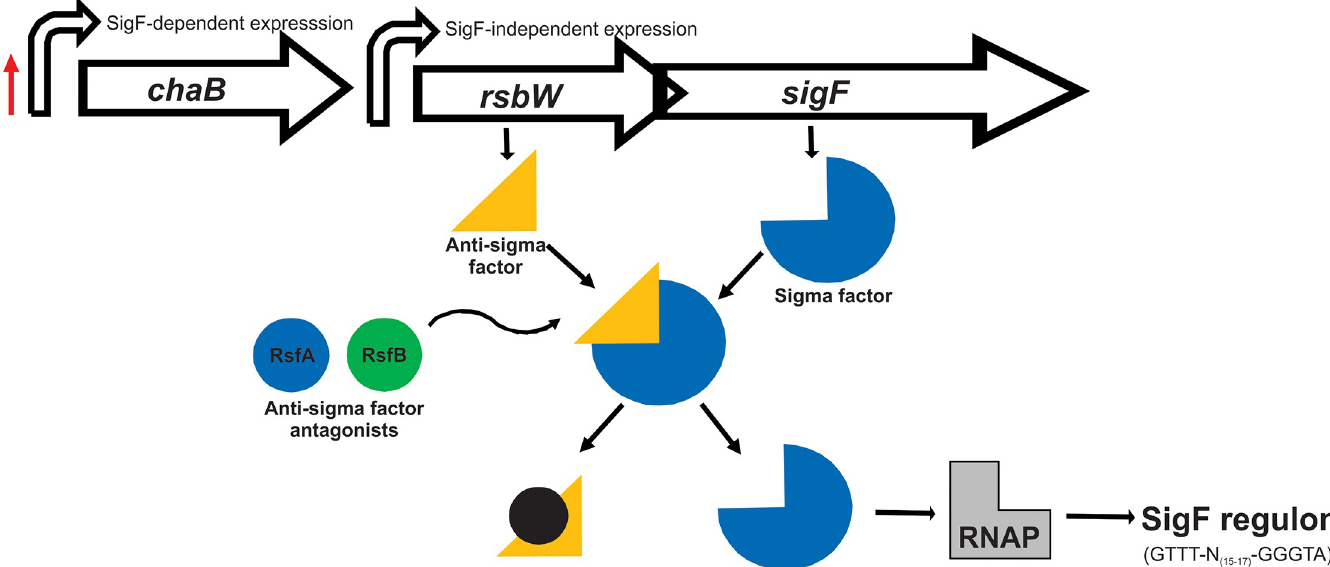
Fig 1. Schematic of the genomic arrangement of sigF from M . smegmatis and its regulation.